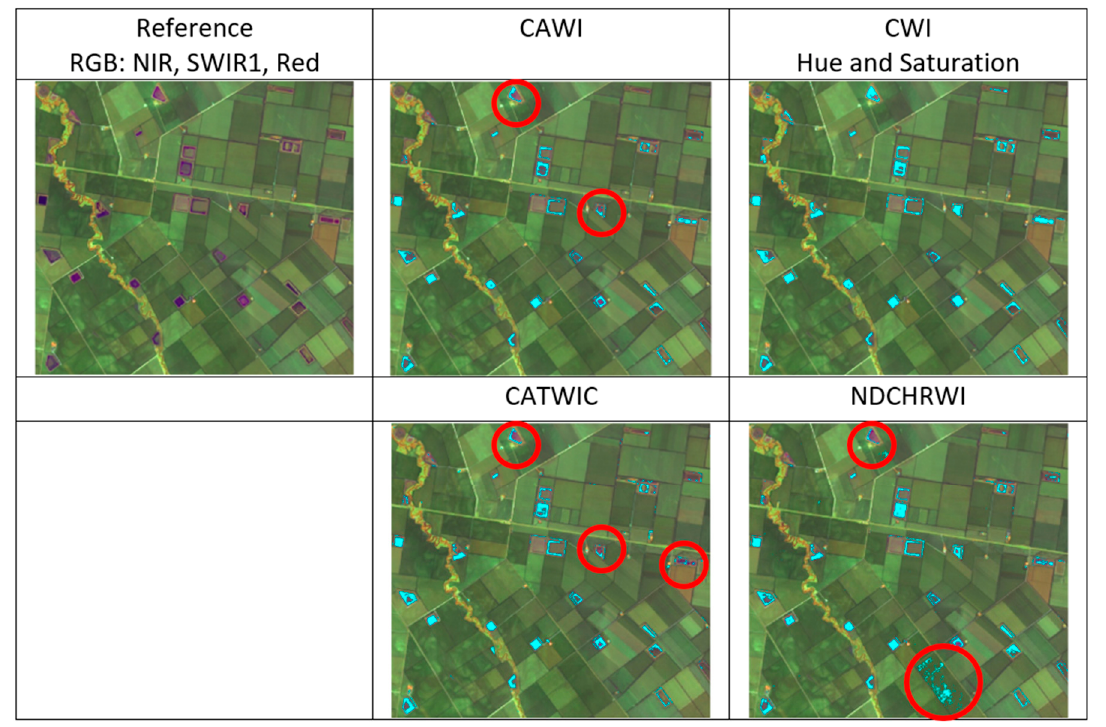
Figure 8. Index performance comparison in a highly irrigated agricultural area. Location: Between the Condamine and Cecil Plains in Queensland, Australia (151.3054, − 27.558). Reference RGB: NIR, SWIR1, Red, min: 0, max: 0.3. Red circles indicate misclassifications.